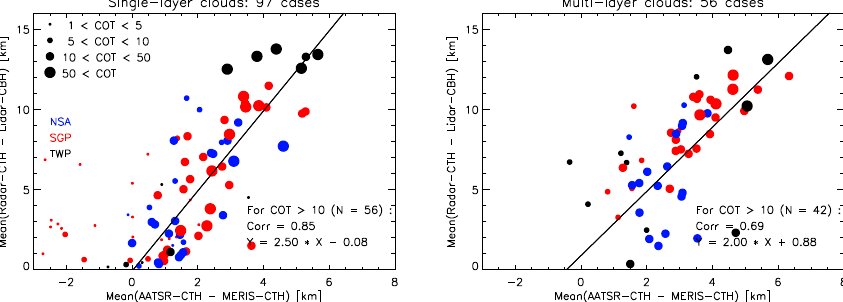
Figure 5. Results of the comparison of mean cloud vertical extent derived from radar and lidar observations to the difference in mean cloud-top height retrieved with AATSR and MERIS.